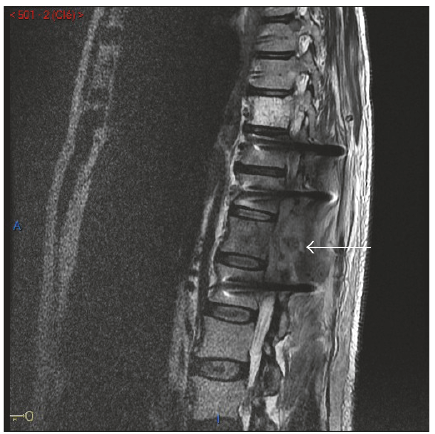
Figure 3: Spinal MRI revealing paravertebral lesions between T11- T12 causing significant mass effect on the conus medullaris.